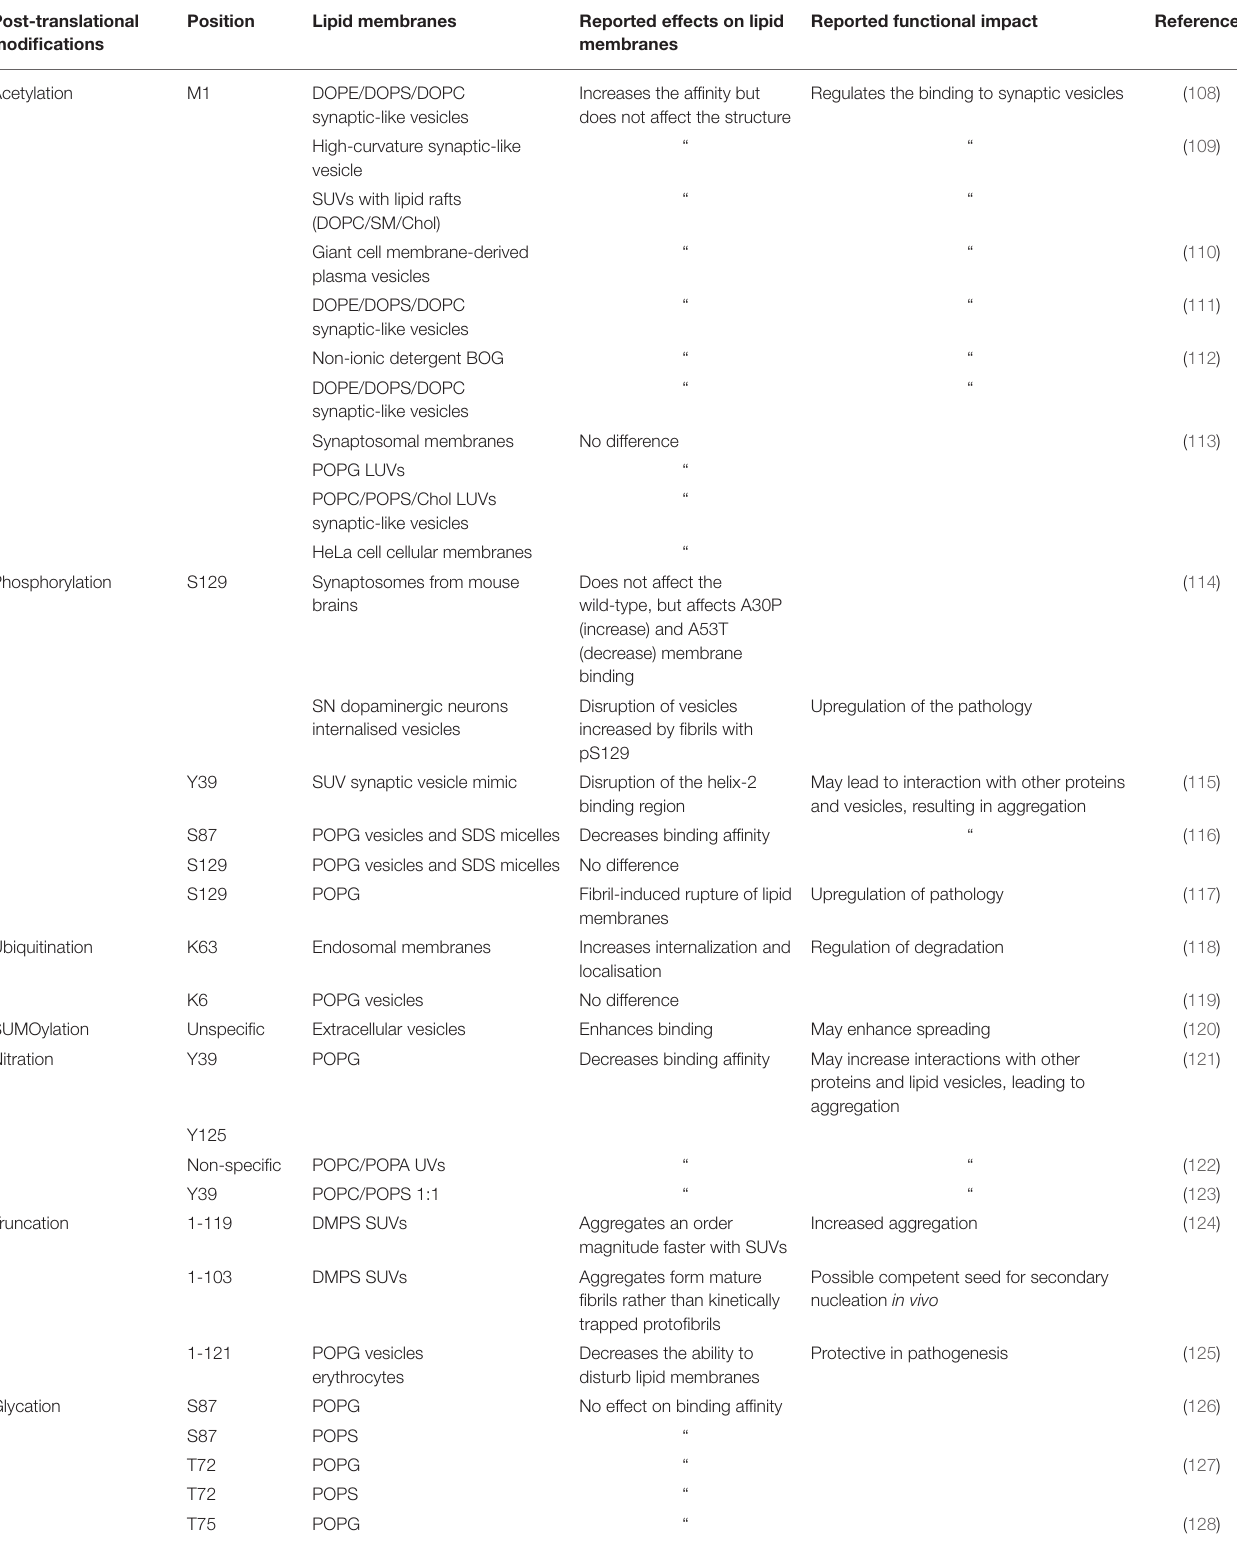
TABLE 1 | Summary of the known post-translational modifications of α -synuclein, and of their effects on its binding to lipid membranes. Post-translational